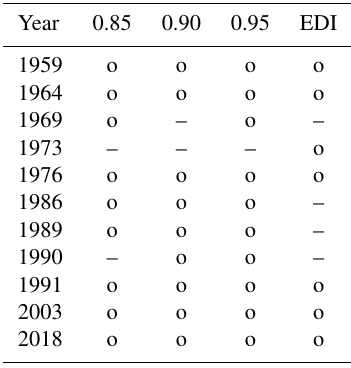
Table 3. Comparison of extreme drought summer half-years (SHYs), between 1951 and 2019, as identified by EDI and the RCN. Bars indicate SHYs identified as not extreme, and open circles indicate SHYs identified as extreme. Years according to EDI are shown in the rightmost column, and years according to the RCN, based on the normalised edge density for the correlation thresholds ρ 0 = 0 . 85, 0.90 and 0.95, are shown in columns two to four.